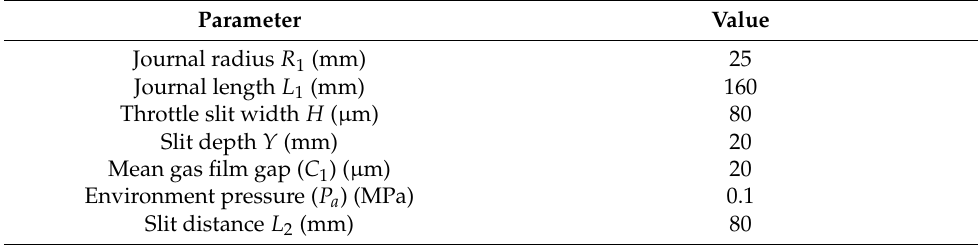
Figure 2. Force model. Table 1. Structural parameters of motorized